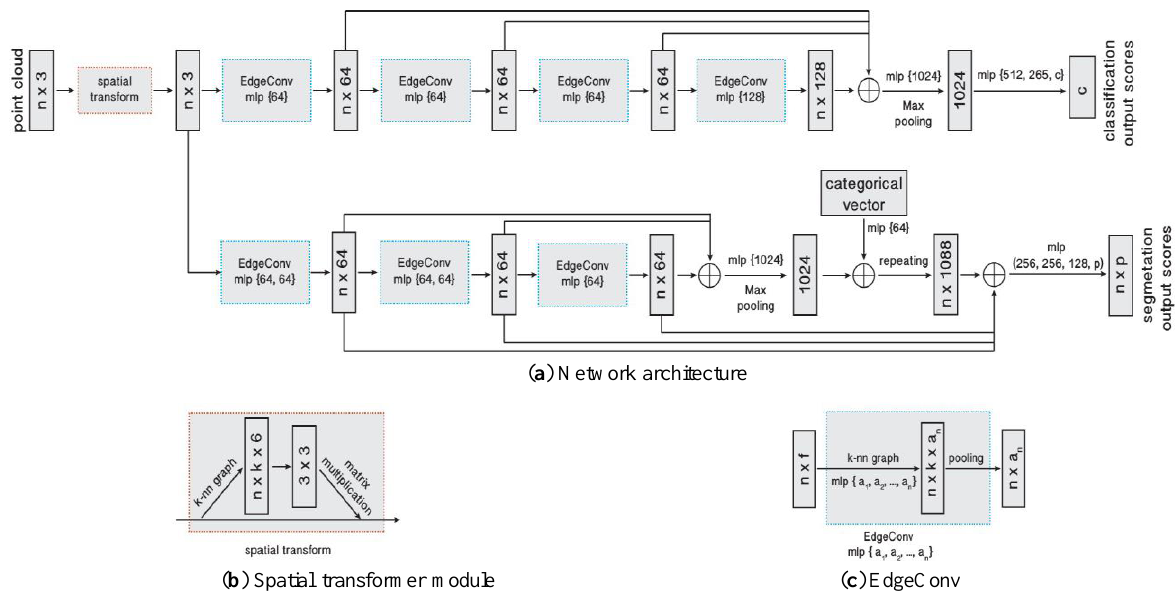
Figure 3. The DGCNN architecture (Wang et al., 2018). ( a ) The top branch shows the classification model architecture while the bottom branch shows a semantic segmentation model architecture; ( b ) A spatial transformation module is used to learn specific transformations from the input point cloud, i.e. to estimate a 3 × 3 transformation matrix by concatenating the coordinates of each point and the coordinate differences between its k -nn neighbors, and then apply point convolutions; ( c ) EdgeConv takes an output tensor of shape ( 𝑛 × 𝑓) , and then applies multi layer perceptron (MLP) operations with a number of neurons defined as {𝑎 1 ,𝑎 2 ,. .. ,𝑎 𝑛 } to compute edge features which finally results in a tensor shape of ( 𝑛 × 𝑎 𝑛 ) after pooling the neighboring